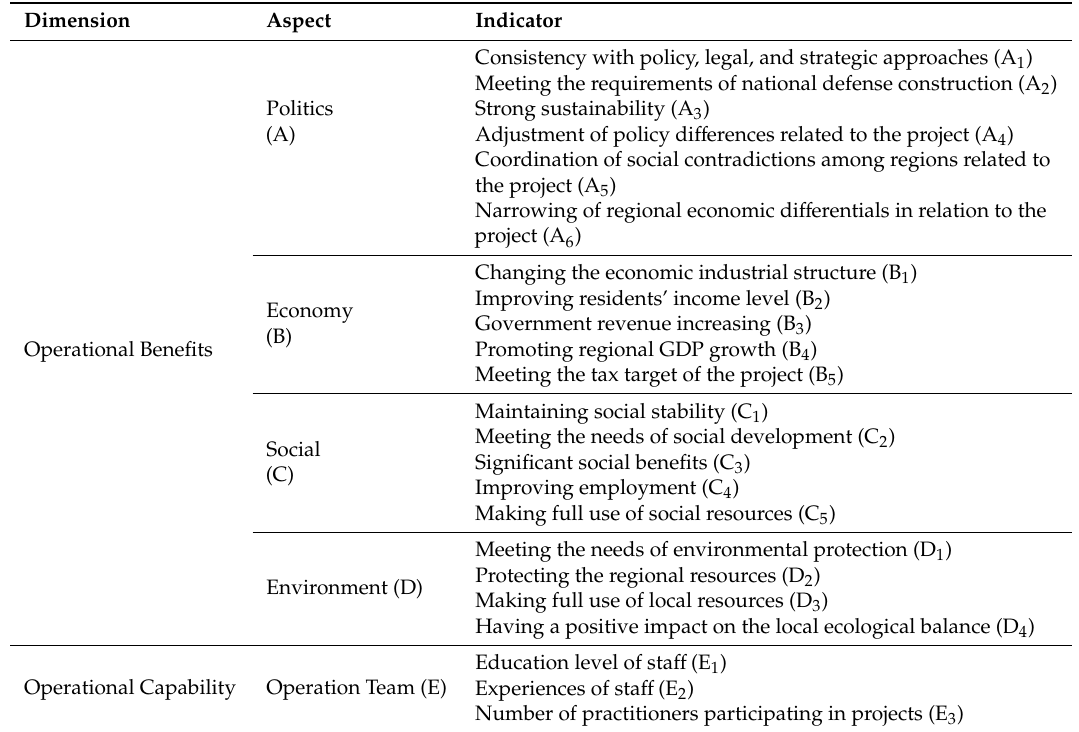
Table 4. Initial indicator